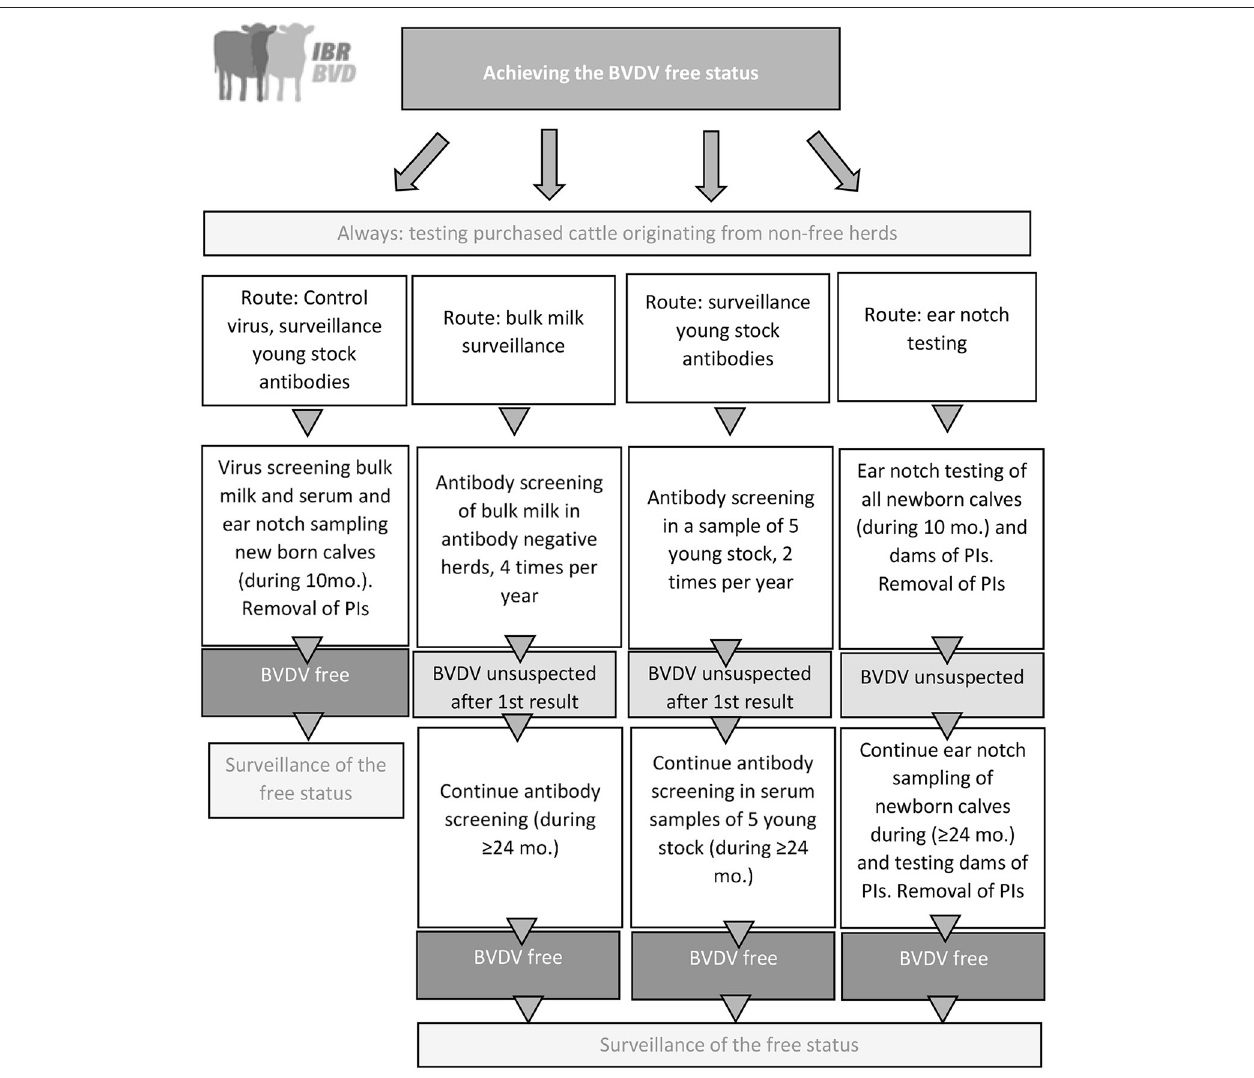
FIGURE 1 | Graphical overview of the national BVDV control program in the Netherlands that was implemented in 2018. PI, Persistently infected animal.